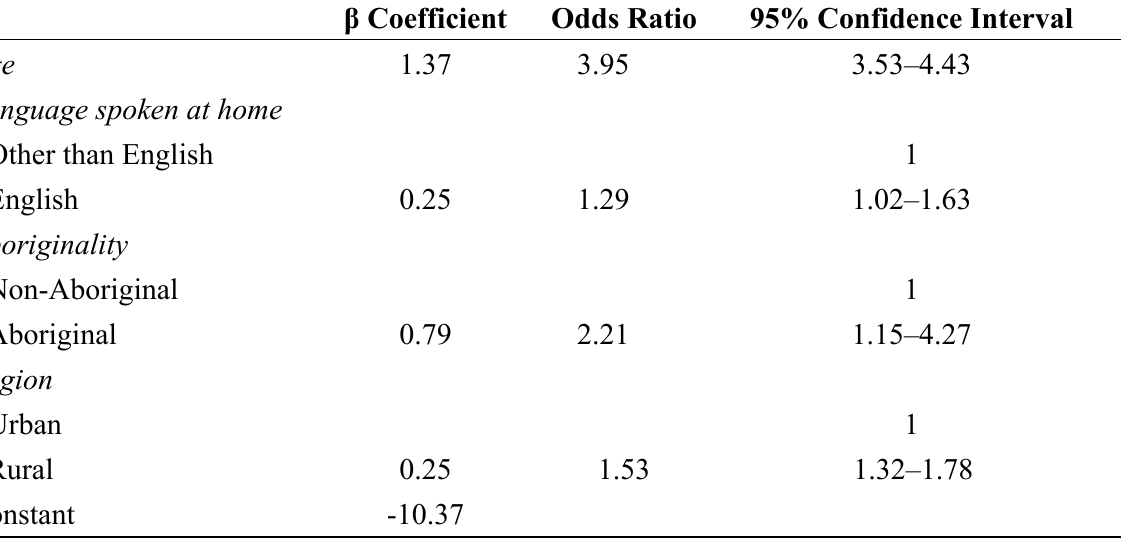
Table 2. Regression coefficient, odds ratios and 95% confidence interval for odds ratios for the factors predicting being edentulous among adult clients of public dental health services in